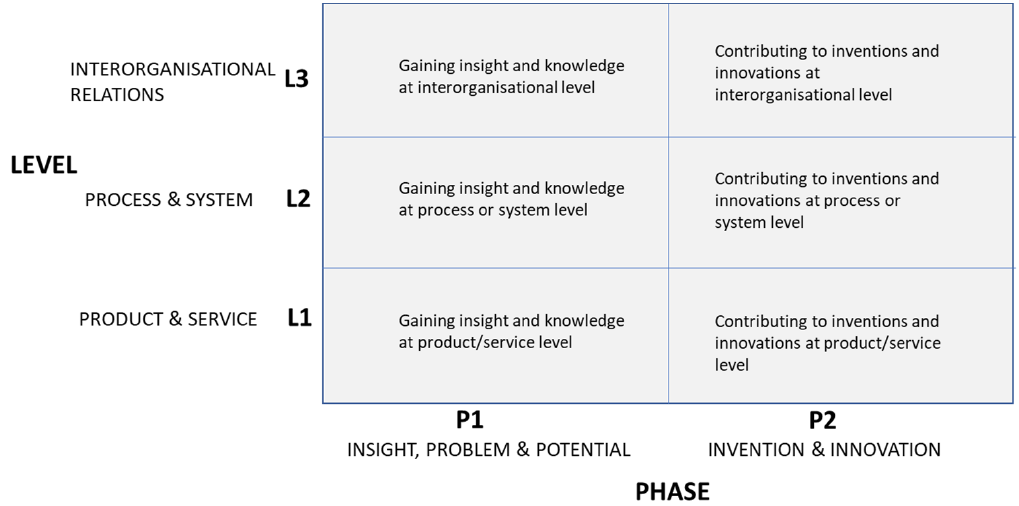
Figure 3. Coding groups by “phase” (P1 and P2) and by “level” (L1, L2, L3).